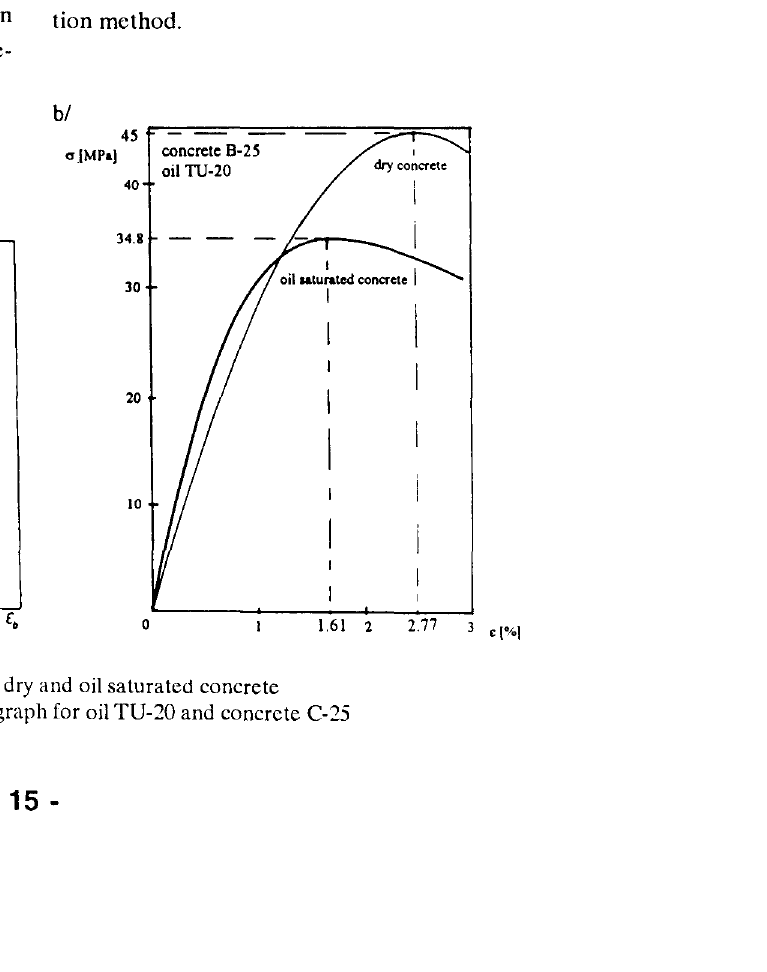
Fig. 3. Variation of concrete C-25 compressive strength during the period of exposure to different oils Contamination of concrete by hydrocarbons gives almost a new material, which behaves differ ently. The results of the stress (cr)- strain (E) relation in dry state and in fully saturated in function of the longitudinal strains arc different. The nonlinear be haviour of strength and strain variations depends on the contents of hydrocarbon and its tvoe. The